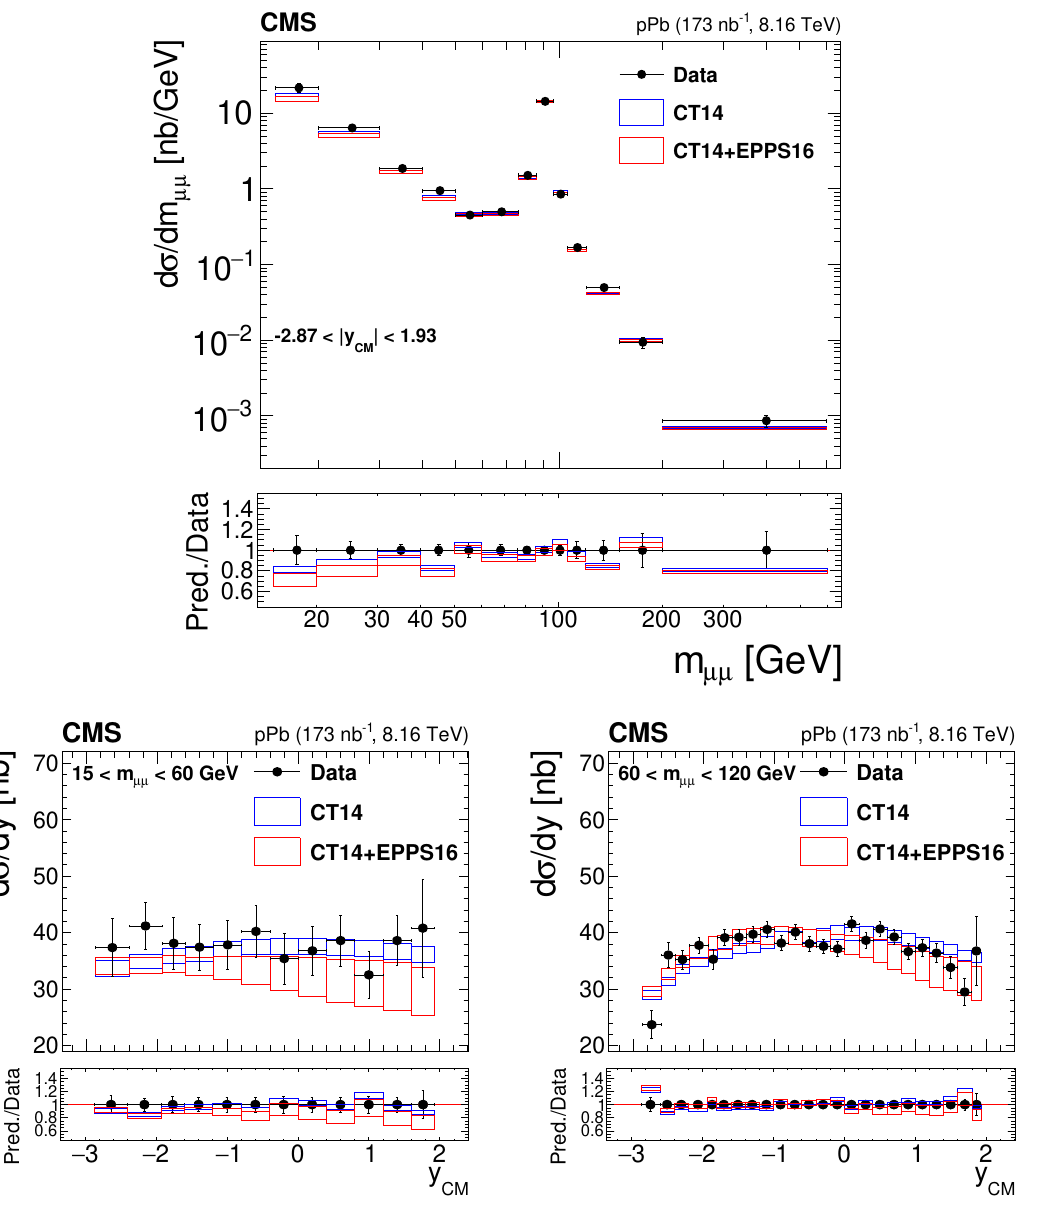
Figure 7 . Differential cross section for the DY process measured in the muon channel, as a function of the dimuon invariant mass (upper) and rapidity in the centre-of-mass frame for 15 < m < 60 GeV (lower left) and 60 < m < 120 GeV (lower right). The error bars on the data mm mm represent the quadratic sum of the statistical and systematic uncertainties. Theory predictions from the powheg NLO generator are also shown, using CT14 (blue) or CT14+EPPS16 (red). The boxes show the 68% confidence level (n)PDF uncertainty on these predictions. The ratios of predictions over data are shown in the lower panels, where the data and (n)PDF uncertainties are shown separately, as error bars around one and as coloured boxes,